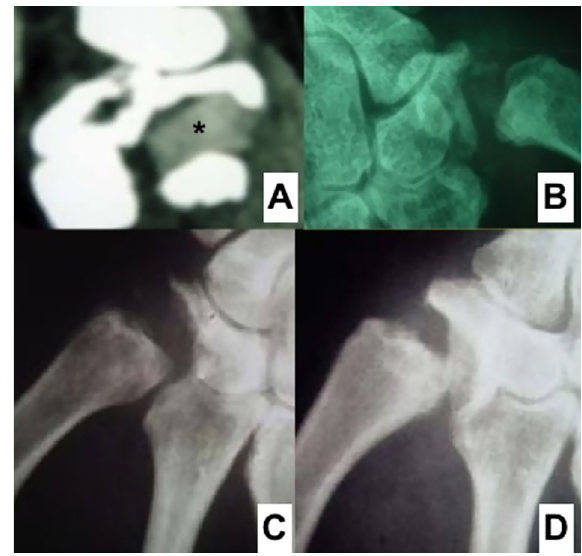
Figure 4. CT scan aspect of a graft (*) in the space created by trapeziectomy (A), slight metaplasia appeared sometimes with time without any clinical consequences (B), Narrowing of the space appeared with high follow-up but less than trapeziectomy alone (C &